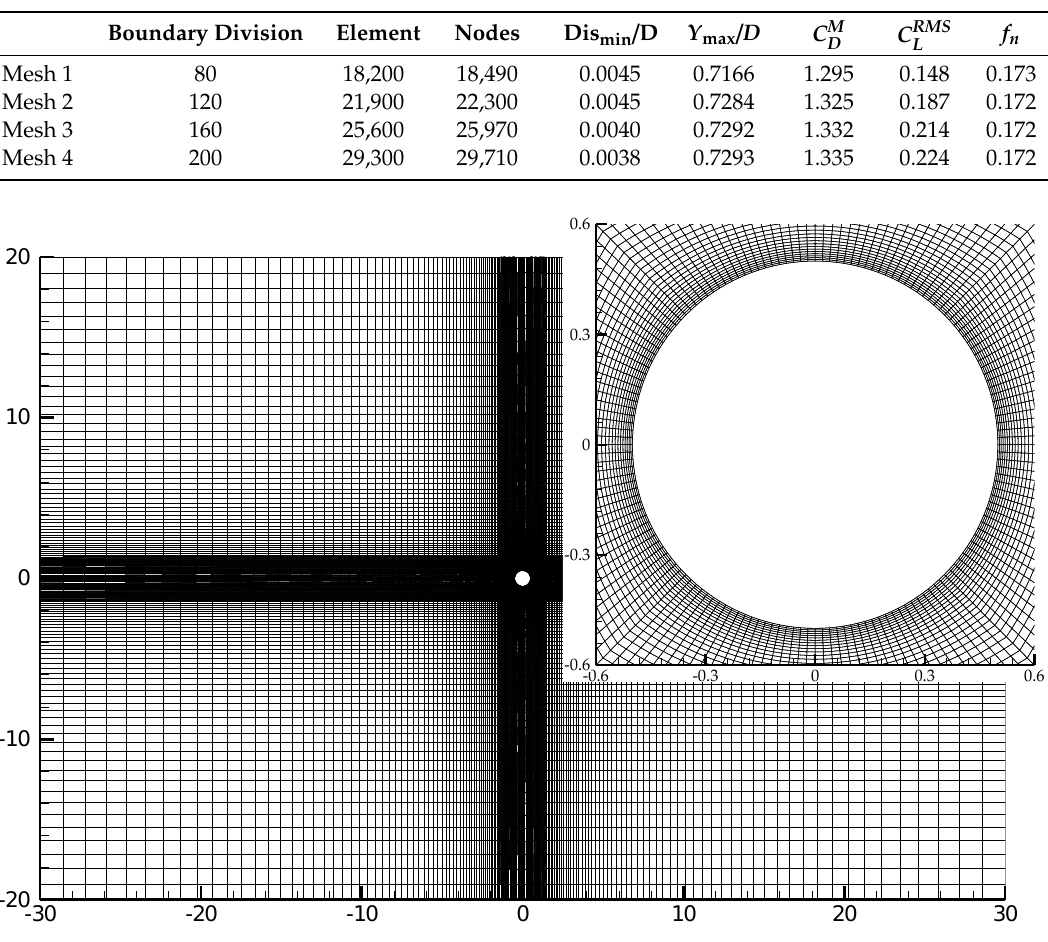
Table 2. Comparisons of numerical results with di ff erent mesh solutions.